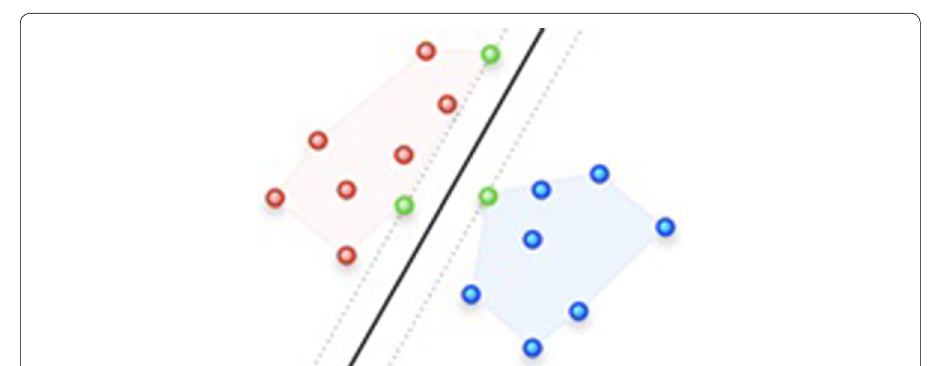
Fig. 5 Support vector machine-data distribution over the hyper